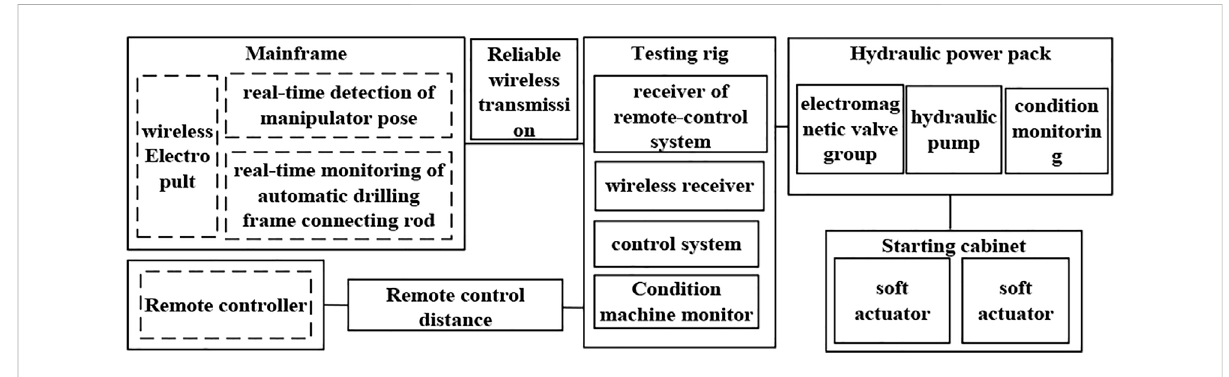
FIGURE 19 General scheme of an electric control system for the mining roof bolter.